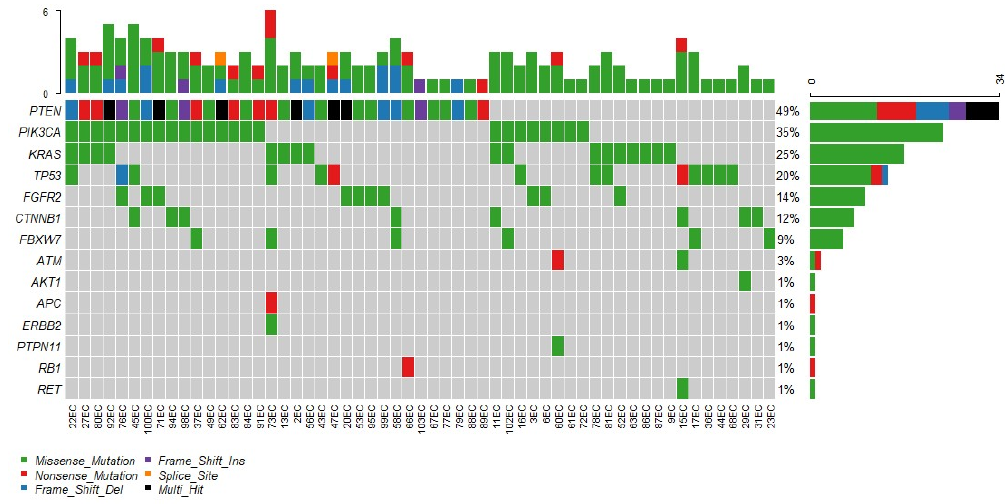
Figure 2. The occurrence and overlapping of additional molecular events. A picture illustrates the main pathways involved in EC genesis. We observed the PIK3CA-PTEN pathway with a frequency close to 50%. TP53 silencing was observed in 20% and the Wnt-pathway in